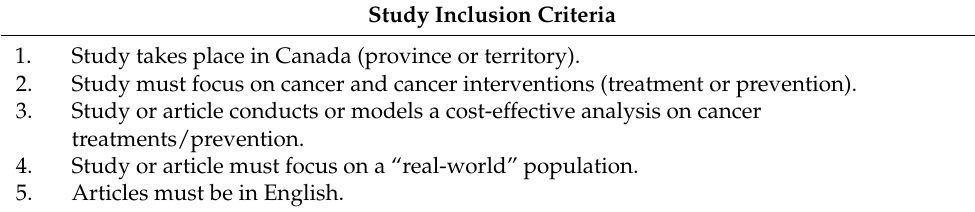
Table 1. Study Inclusion and Exclusion